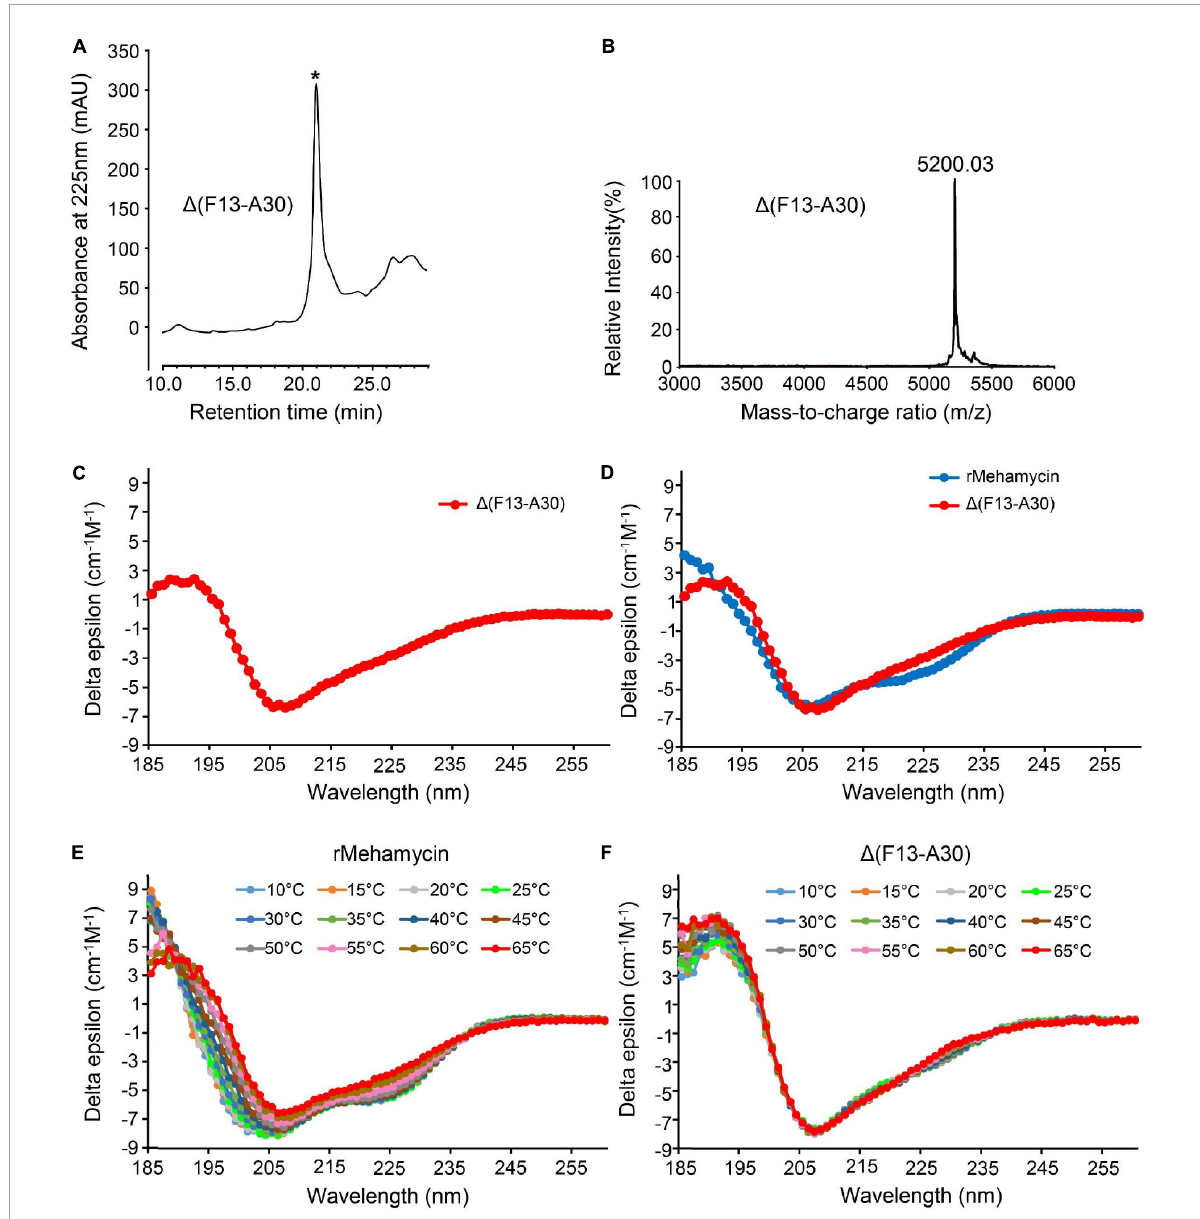
FIGURE3 Characterization of mehamycin-del (F13-A30). (A) Reverse phase high-performance liquid chromatography (RP-HPLC) showing the retention time (TR) of (cid:49) (F13-A30), indicated by an asterisk. (B) MALDI-TOF MS of HPLC-purified (cid:49) (F13-A30). (C) CD spectra of (cid:49) (F13-A30) at room temperature. (D) CD spectral superimposition of mehamycin and (cid:49) (F13-A30) at room temperature. (E,F) CD spectra of mehamycin and (cid:49) (F13-A30), measured at 10–65 ◦